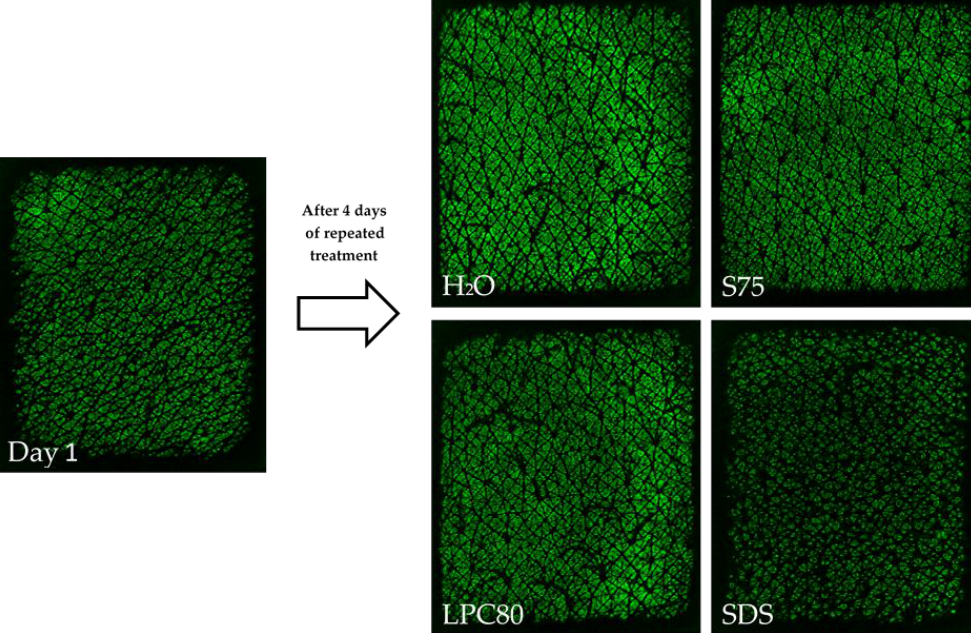
Figure 4. Example of capacitive images of human forearm skin acquired with the fingerprint sensor Epsilon ® . The image on the left shows a representative measurement of untreated skin at the beginning of the study on day one; on the right-hand side, images of the volunteer’s treated skin sites after repeated treatment with water, S75, LPC80 or SDS after four days.